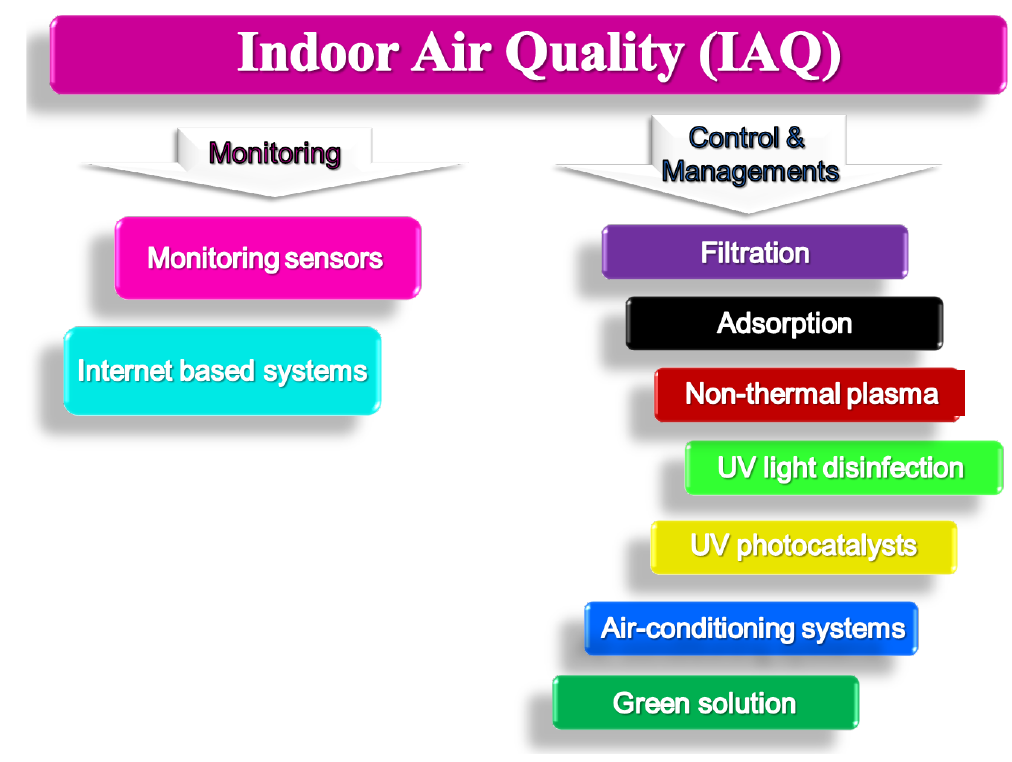
Figure 2. Indoor air quality — Monitoring, control, and management.